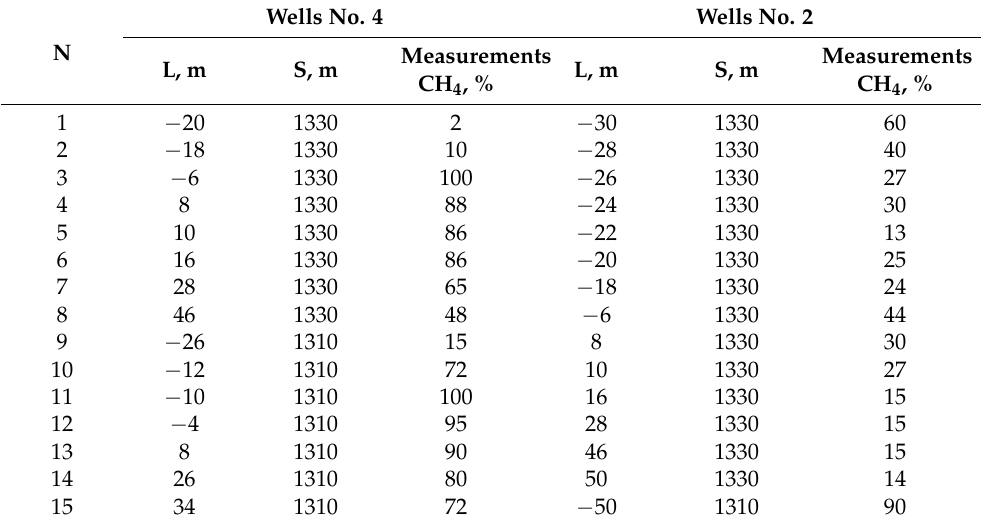
Table 1. Experimental data on methane concentration in degassing wells.